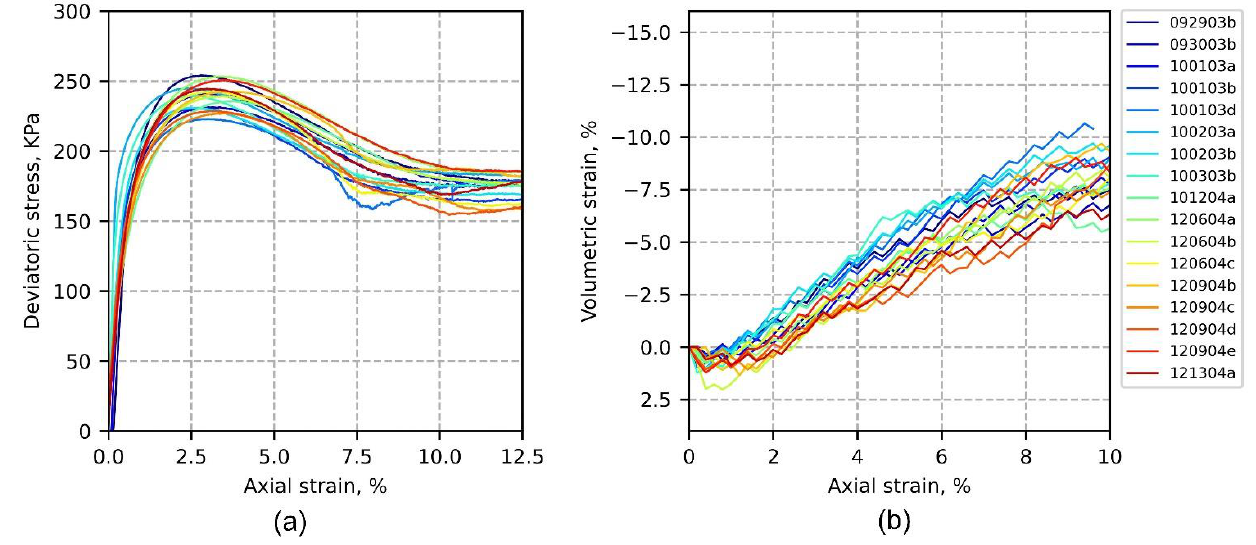
Figure 1. Triaxial stress–strain curves of the 17-test ensemble ( a ) and axial strain–volumetric strain curves of the 17-test ensemble ( b ).